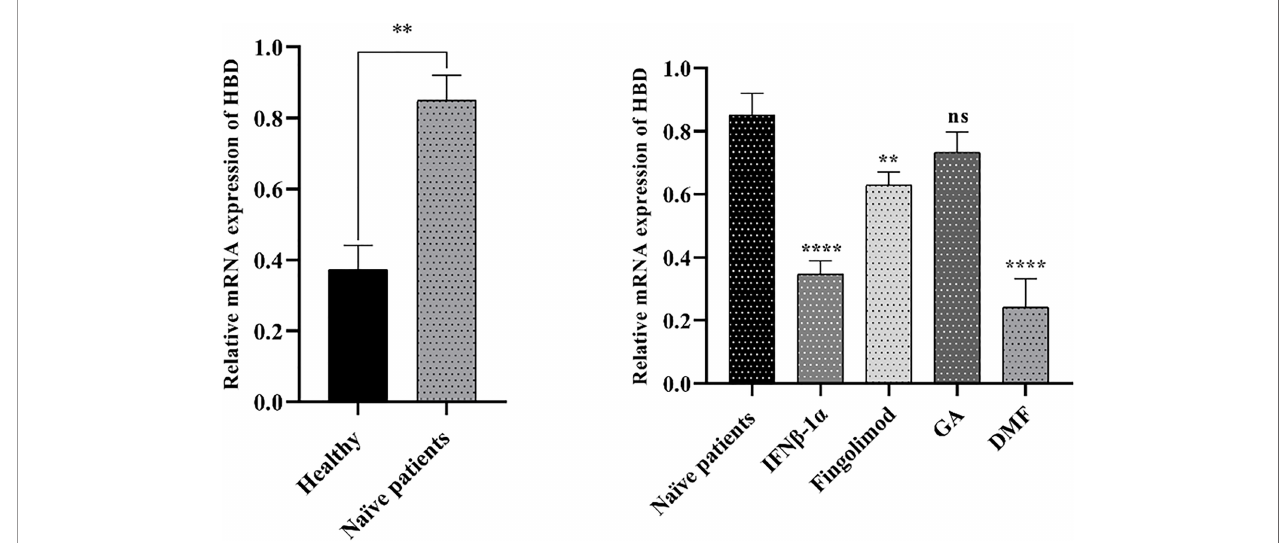
FIGURE 9 | The expression levels of the HBD in the MS patients and healthy groups. HBD mRNA expression was signi fi cantly up-regulated in the treatment-naïve MS patients compared with healthy individuals (left chart). Besides, the expression of HBD in MS patients treated with fi ngolimod, DMF, and IFN b -1 a showed a signi fi cant decrease compared to the treatment-naïve MS patients (right chart). GAPDH was used as a housekeeping gene; data are expressed as the mean of 2 − D ct (± SD). **P-value< 0.01, ****P-value< 0.0001, and ns, not signi fi